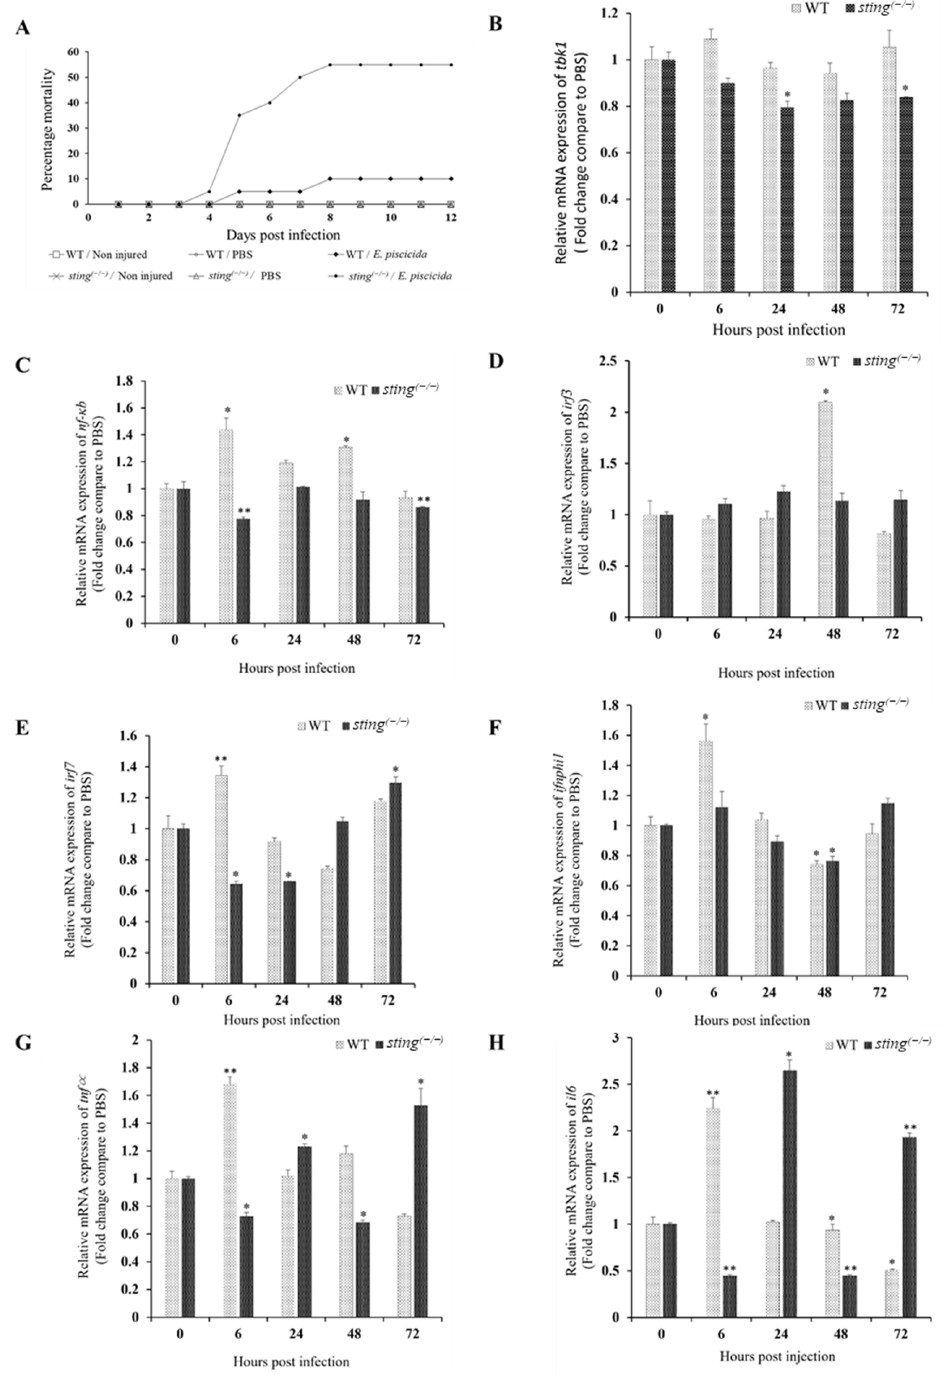
Figure 4. E. piscicida challenge in sting ( − / − ) and WT zebrafish. ( A ) Percent mortality of sting ( − / − ) and WT zebrafish post- E. piscicida infection. Two-month-old juvenile zebrafish were wounded, and E. piscicida infection was performed via bath immersion for 5 h. ( B – H ) Temporal transcription of tbk1 , nf- κ b , irf3 , irf7 , ifnphi1 , tnf α , and il6 in juvenile sting ( − / − ) and WT zebrafish upon E. piscicida infection. ef-1 α expression was used as an internal control to analyze relative mRNA expression using the Livak bars and the asterisk (* p < 0.01, ** p < 0.001) indicate the standard deviation and significantly